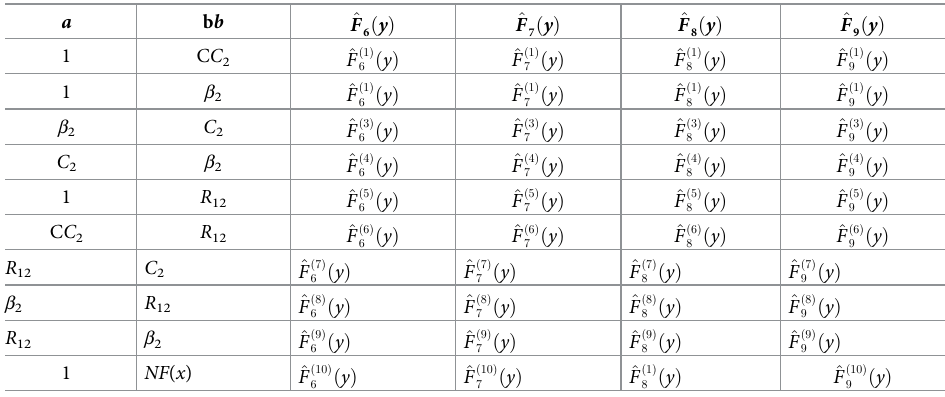
Table 1. Some members of the adapted and proposed distribution function